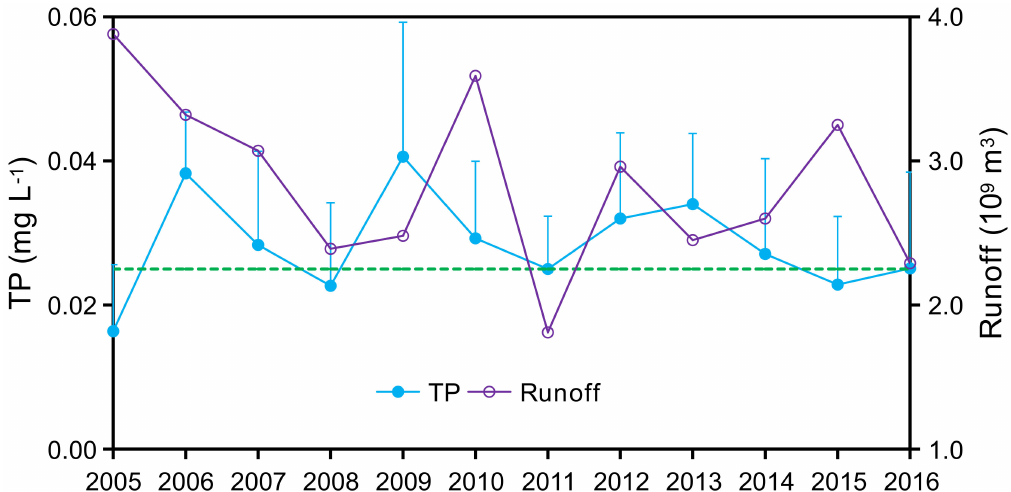
Figure 3. Annual runoff volume and annual average total phosphorus (TP) concentrations in Zhaoshandu Reservoir (2005–2016). The vertical error lines are the standard deviation of TP, and the horizontal dotted line represents the Grade II water quality standard goal for TP (0.025